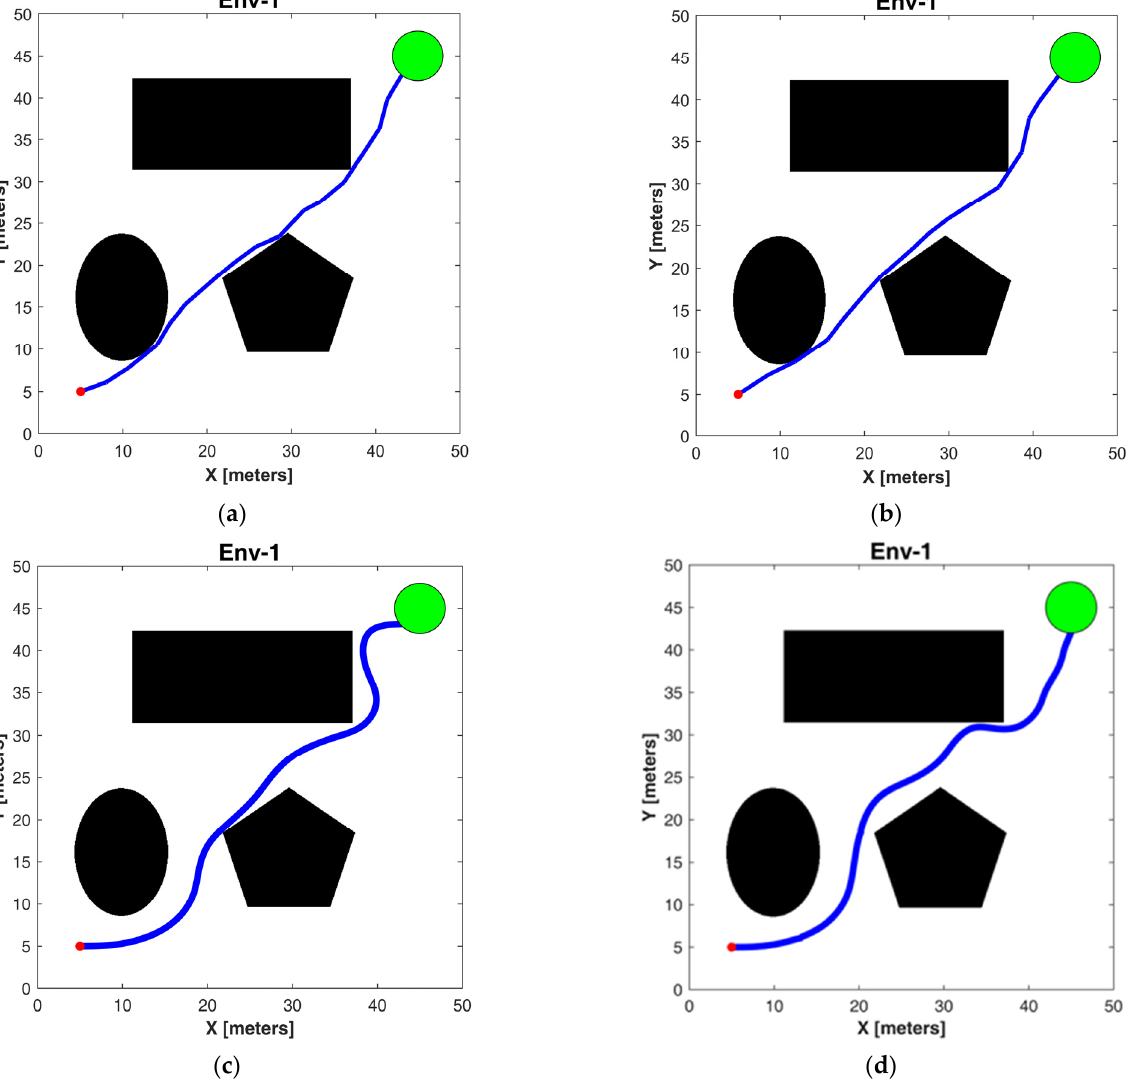
Figure 8. Results of path under scenario 1: ( a ) RRT*; ( b ) Informed ‐ RRT*; ( c ) spRRT; ( d ) spRRT ‐ Informed.